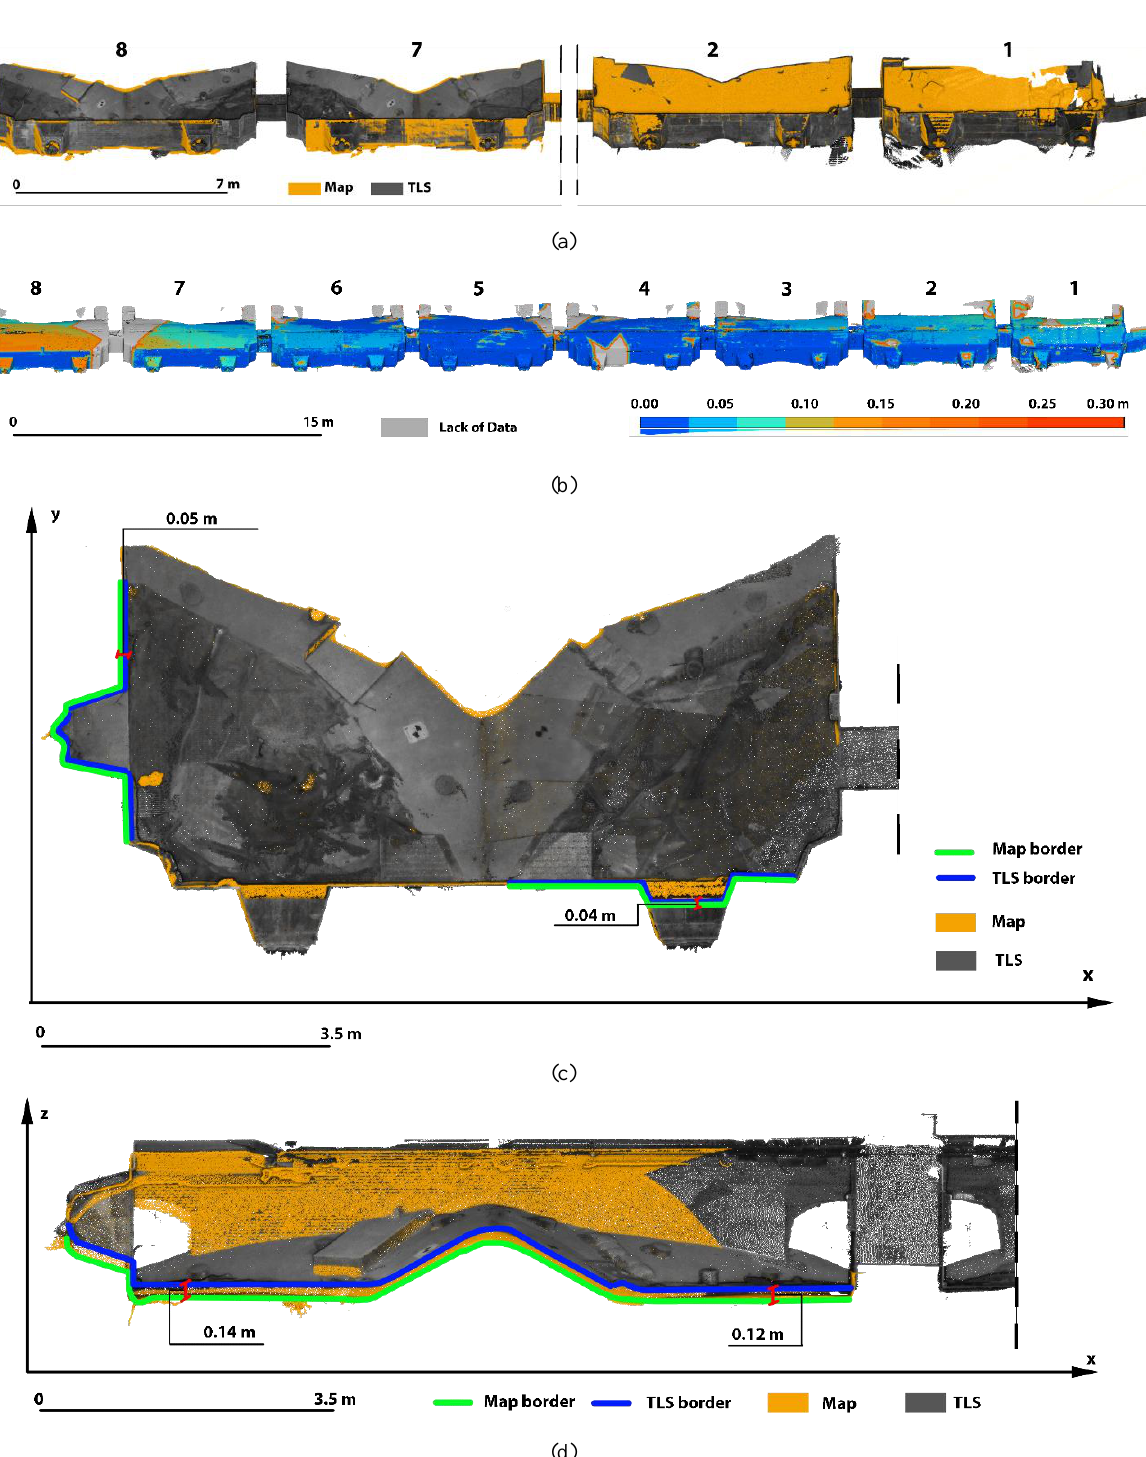
Figure 5. (a) Ground truth and spatial map comparison. (b) Ground truth with color-coded deviations from spatial map. (c) xy plane detail (bay 8) and (e) xz plane detail (bay